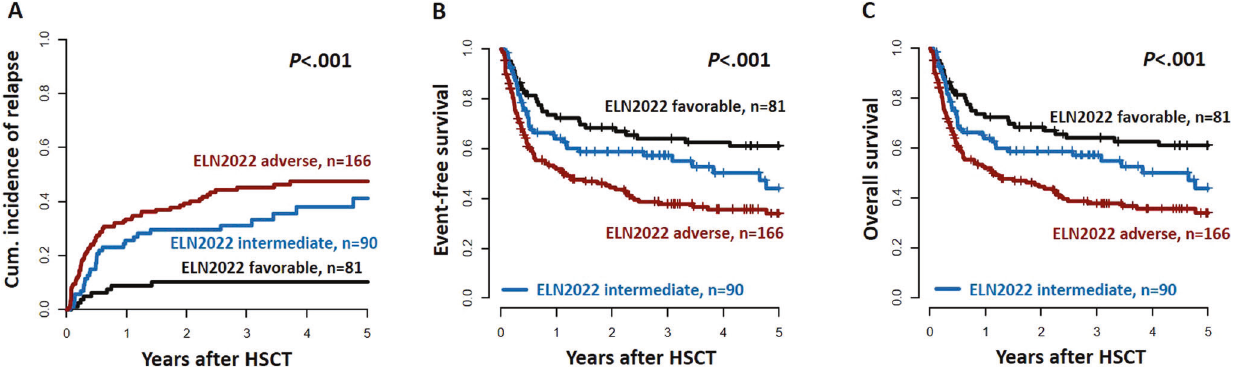
Fig. 2 Outcomes according to the ELN2022 genetic risk groups at diagnosis within patients transplanted in fi rst morphologic remission ( n = 337). A Cumulative incidence of relapse, B Event-free survival, and C Overall